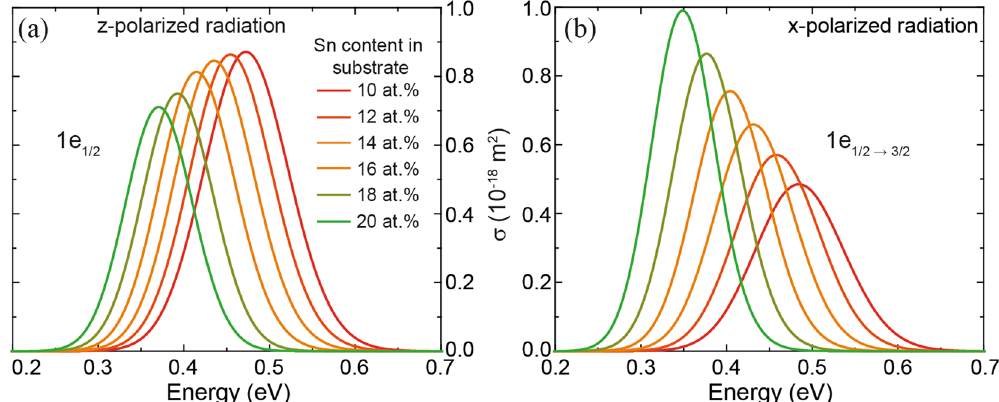
Figure 9. Optical cross section σ ε for z-polarized radiation for Δ m f = 0 ( a ) and x- polarized radiation for if = ± 1 ( b ) in a Ge Δ m f 0.82 Sn 0.18 /Si 0.10 Ge 0.74 Sn 0.16 QD on various GeSn